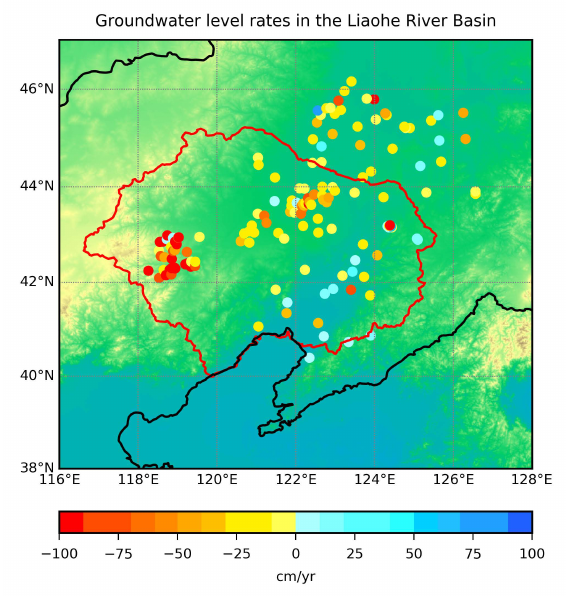
Figure 8. Groundwater level rates based on ground monitoring wells in the LRB and its surroundings during